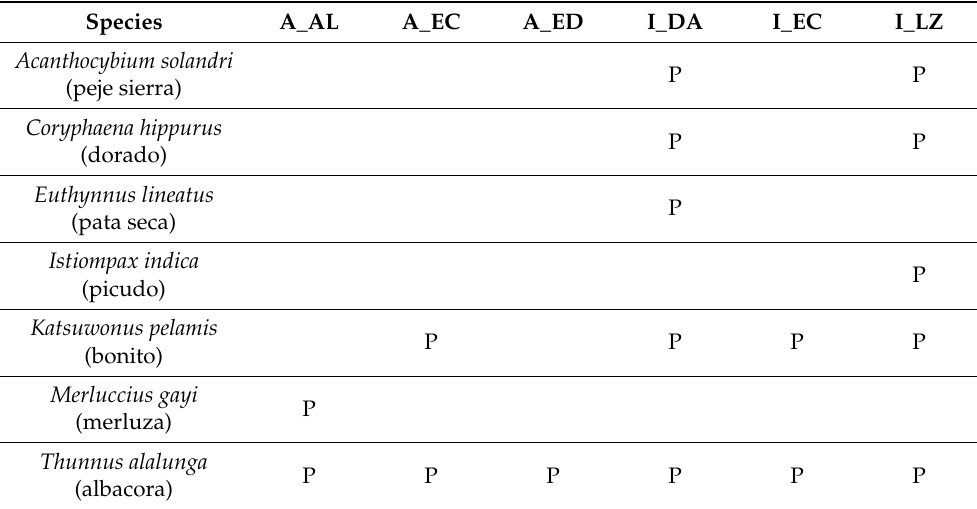
Table 3. Species reported by each vessel’s crew as targeted fish (P) in catch. Spanish name reported in parenthesis. Peje sierra is also sometimes used for Scomberomorus sierra and albacora may sometimes be used for Thunnus albacares and T. obesus